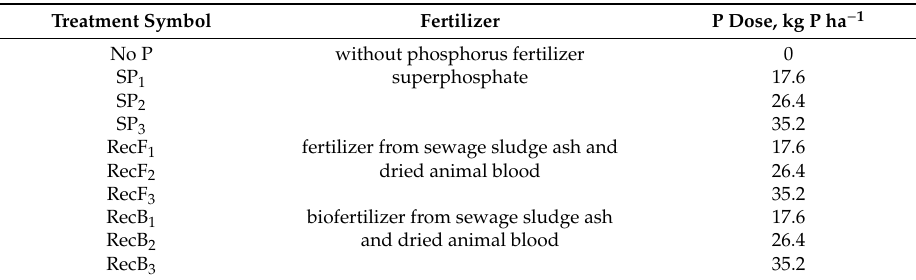
Table 4. Fertilization treatments compared in the experiments.